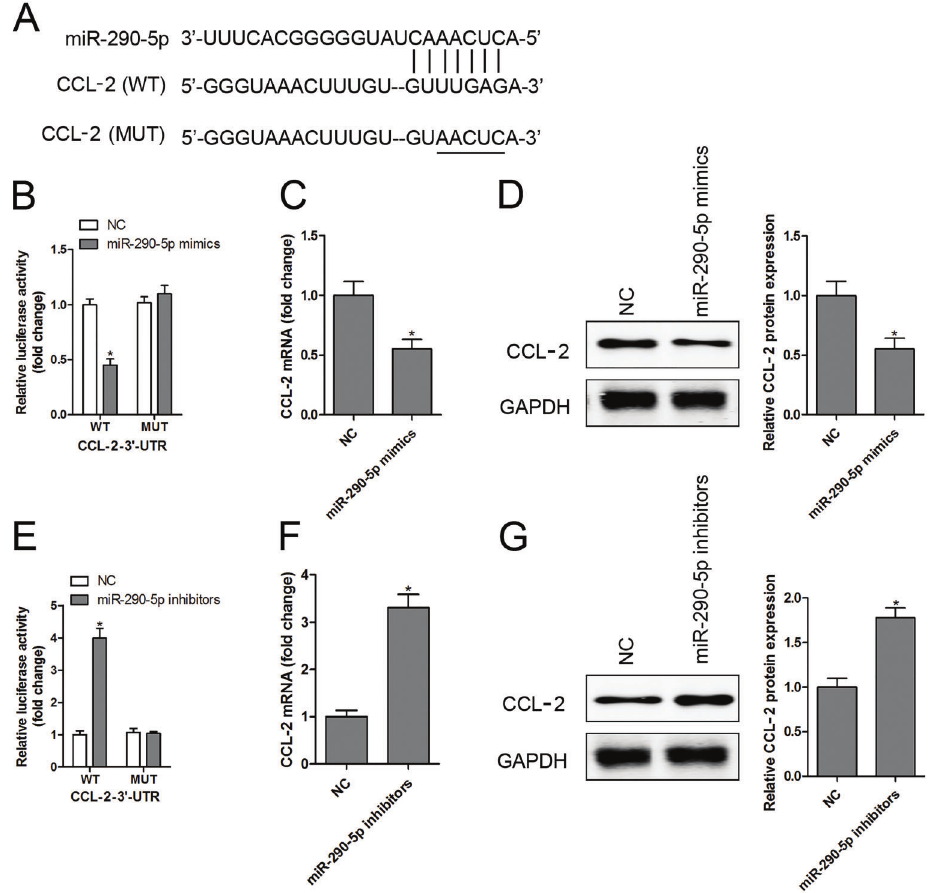
Figure 5. CCL-2 is a direct target gene of miR-290-5p. Schematic representation of the putative miR-290-5p binding site in the 3 0 -untranslated regions (3 0 UTR) of CCL-2 was predicted by the online database ( A ). Mouse podocytes cells (MPC5) were co-transfected with the wild type (WT) and mutant (MUT) of CCL-2-3 0 -UTR and miR-290-5p mimics, and luciferase activity ( B ), mRNA ( C ), and protein ( D ) of CCL-2 were measured. After transfection with the WTand MUTof CCL-2-3 0 -UTR and miR-290-5p inhibitors, luciferase activity ( E ), mRNA ( F ), and protein ( G ) of CCL-2 were measured. Data are reported as means ± SD (n=3 per group). *P o 0.05 compared with the normal control (NC) group